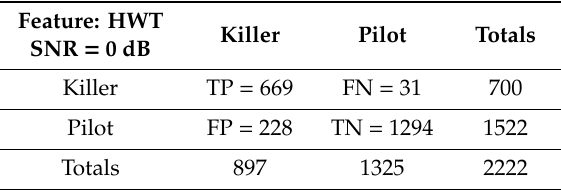
Table 8. Classification results: HWT, SNR = 0